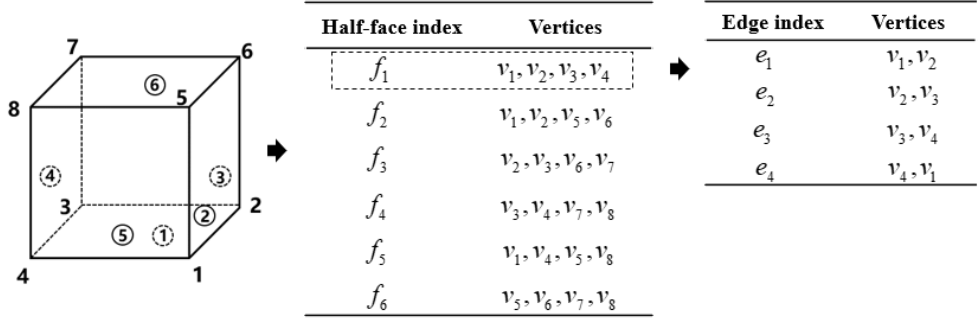
Figure 4. Local numbering conventions and implicit topology information for 3-D elements. The circled numbers correspond to local face IDs, and the unmarked ones correspond to local vertex IDs in the standard 3-D element.